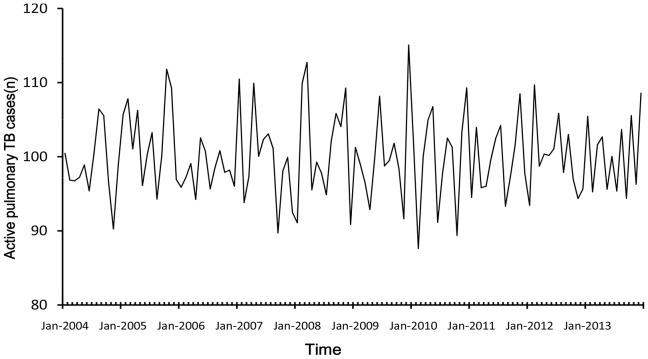
The irregular noise component of time series.